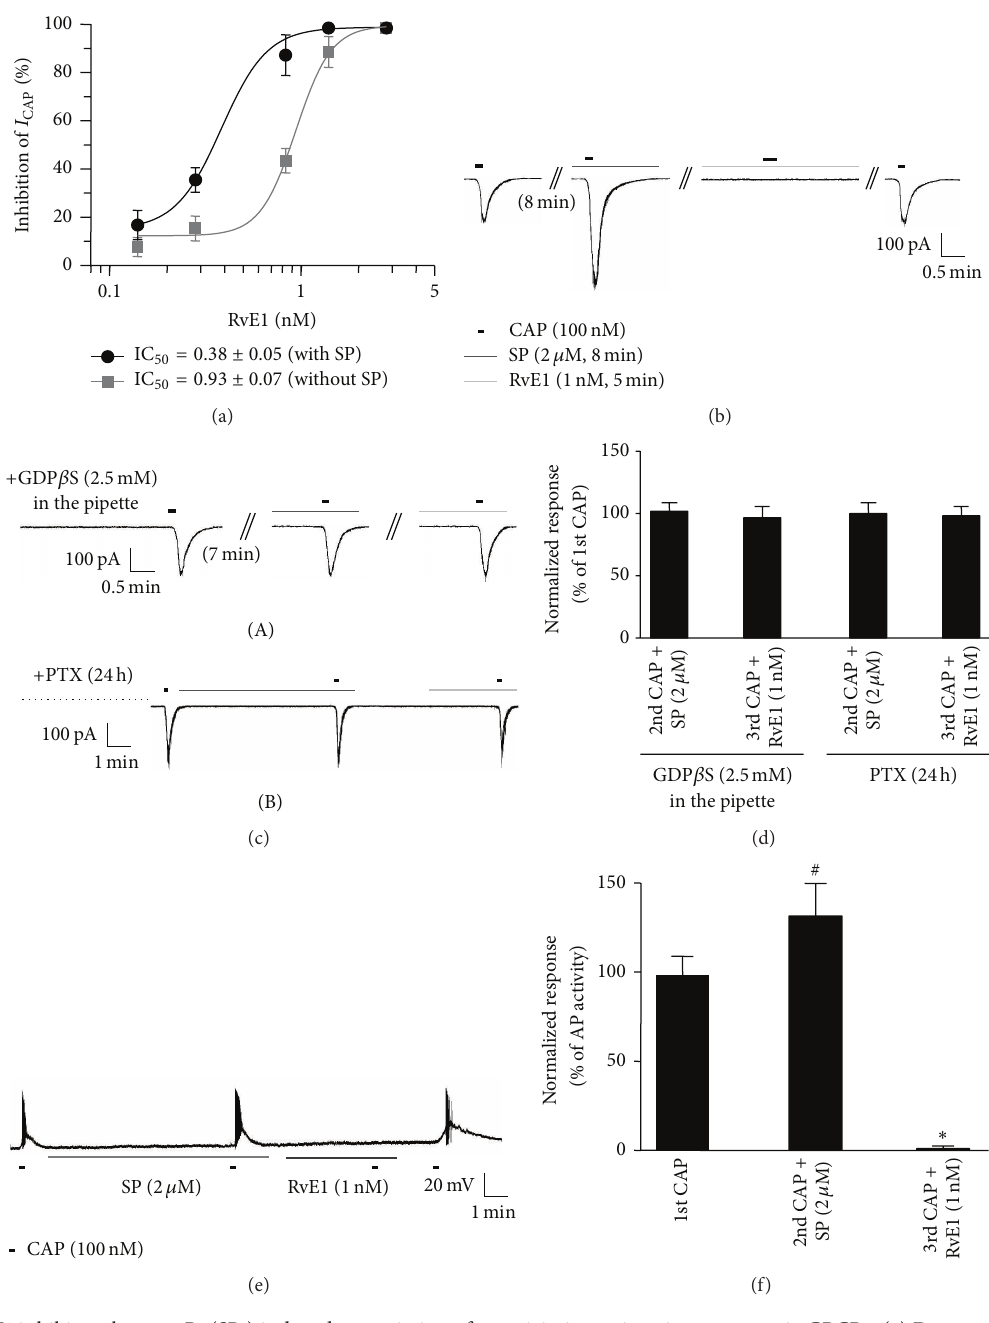
Figure 3: RvE1 inhibits substance P- (SP-) induced potentiation of capsaicin in nociceptive neurons via GPCRs. (a) Dose response curve of RvE1-induced inhibition of TRPV1 currents in small-sized DRG neurons of normal condition (circle, black line) and in SP-treated small-sized DRG neurons (square, gray line). Inset: IC 50 of TRPV1 current inhibition in normal condition and SP-treated DRG neurons, respectively. (b) RvE1 (1nM, 5 min) completely inhibited substance P- (2 𝜇 M, 8 min) induced potentiation of capsaicin-activated currents in small-sized DRG neurons. 𝑛 = 12 . ((c) (A)) Intracellular perfusion of GDP 𝛽 S (2.5 mM, 8 min) blocks both the enhancement and inhibitory effects of capsaicin by SP and RvE1, respectively ( 𝑛 = 12 ). ((c) (B)) Pretreatment of DRG cultures with PTX (0.5 𝜇 g/mL, 18–24h) blocks both the enhancement and inhibitory effects of capsaicin by SP and RvE1, respectively ( 𝑛 = 10 ). (d) Summary of GDP 𝛽 S and PTX blocking the inhibition of SP- induced increases in capsaicin currents and RvE1-mediated inhibition of TRPV1. (e) Current-clamp recording showing that the number of capsaicin-induced action potentials is increased by SP (2 𝜇 M, 8 min) and this increase is completely inhibited by RvE1 (1nM, 5 min). 𝑛 = 10 . (f) Summary of the number of action potentials. Results are presented as the mean ± SEM. ∗ 𝑃 < 0.05 ; 𝑡 -test versus second capsaicin treatment with SP. # 𝑃 < 0.05 ; 𝑡 -test versus third capsaicin treatment with